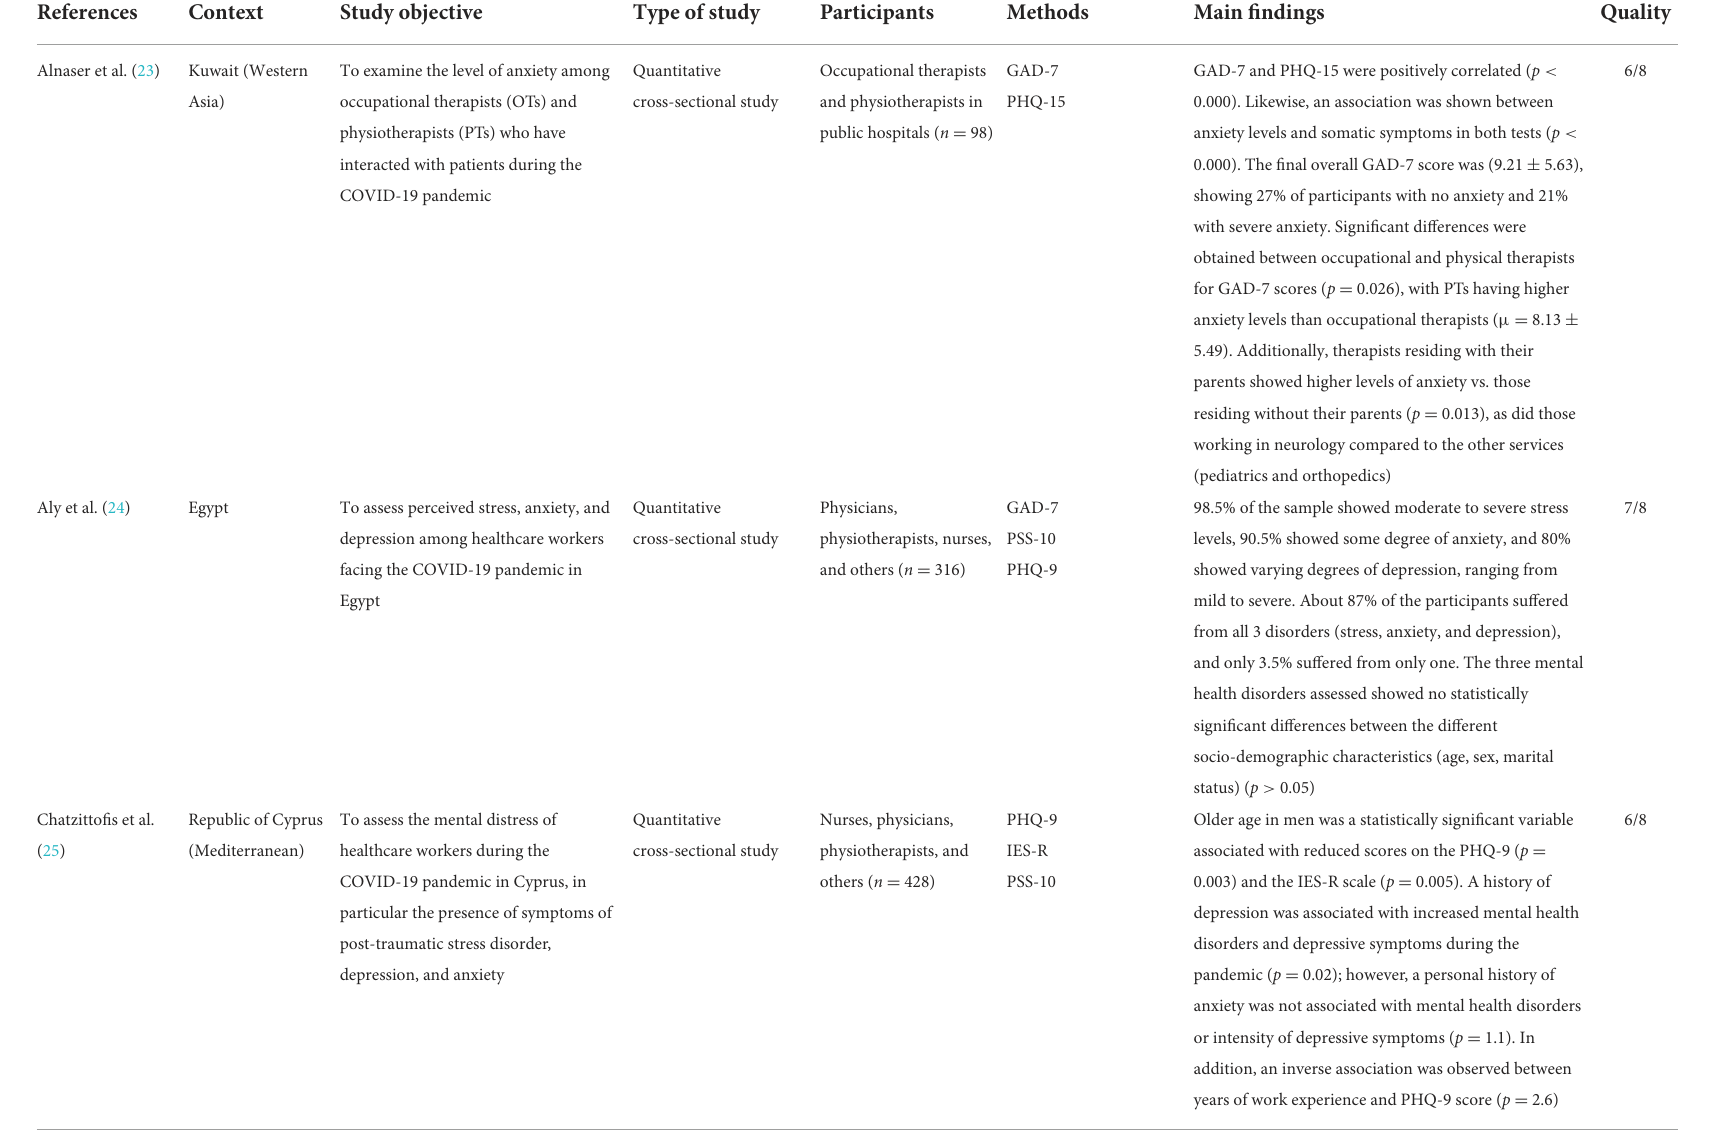
TABLE 4 Characteristics of the studies included in the systematic review (rehabilitation and COVID-19, Spain,